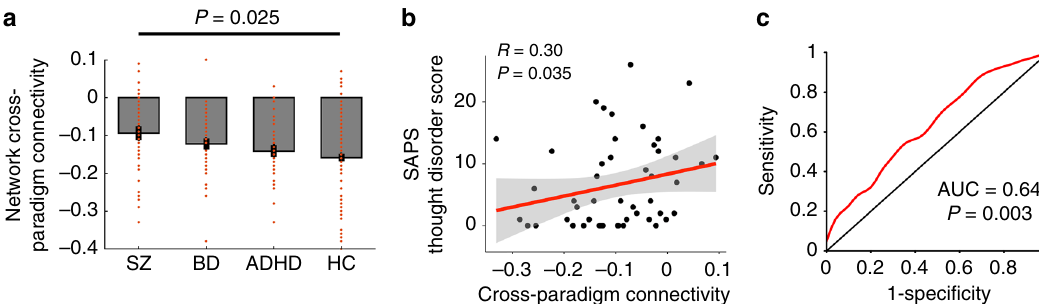
Fig. 3 The presence of the observed network alteration in the CNP data. a Signi fi cant group differences were shown for the mean cross-paradigm connectivity of the identi fi ed network, which was driven by the differences between schizophrenia and controls. SZ schizophrenia, BD bipolar disorder, ADHD attention de fi cit hyperactivity disorder, HC healthy control. b The network alteration was signi fi cantly correlated with scores of SAPS thought disorder subscale in patients with schizophrenia. c Receiver operating characteristic curve for distinguishing patients with schizophrenia from healthy controls. The area under curve was signi fi cantly higher than that can be achieved by chance, per permutation testing. Error bars indicate standard